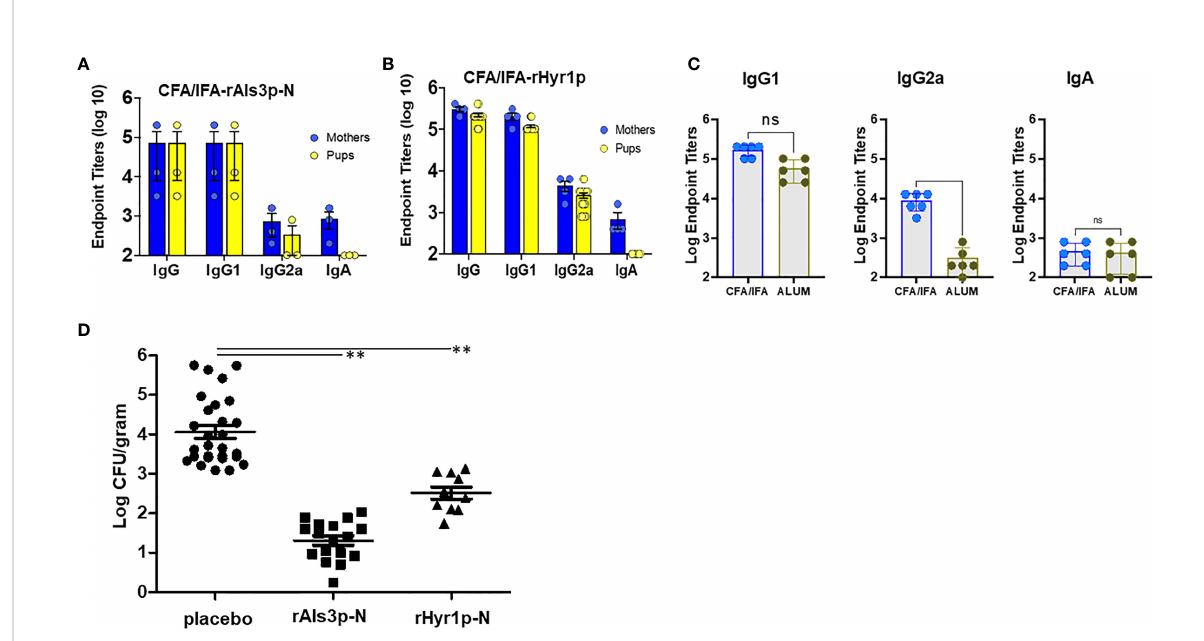
FIGURE 1 Active vaccination of Female BALB/c mice induce robust antibody titers that cross through placenta to induce protection in their newborn mice against C. albicans infection. Female BALB/c mice (6-weeks old) were vaccinated with Als3p-N or Hyr1p-N vaccine adjuvanted with CFA/IFA or adjuvant alone (placebo group) on day 0, 21 and 35. On day 35, mice were mated and kept in cages until the pups were delivered. Sera were obtained on day 6 post- partum both from mothers and their pups for antibody determination (A-C) . Als3p-N vaccinated female BALB/c mice (A) and Hyr1p-N vaccinated mice (B) induce robust total IgG and IgG isotype and IgA antibodies, which ef fi ciently transferred (equivalent titers) to their pups (except IgA). (C) CFA/IFA adjuvanted Hyr1p-N vaccine showed similar IgG1 and IgA isotype antibodies, but higher levels of IgG2a in CFA/IFA vaccinated mice. (D) Fungal